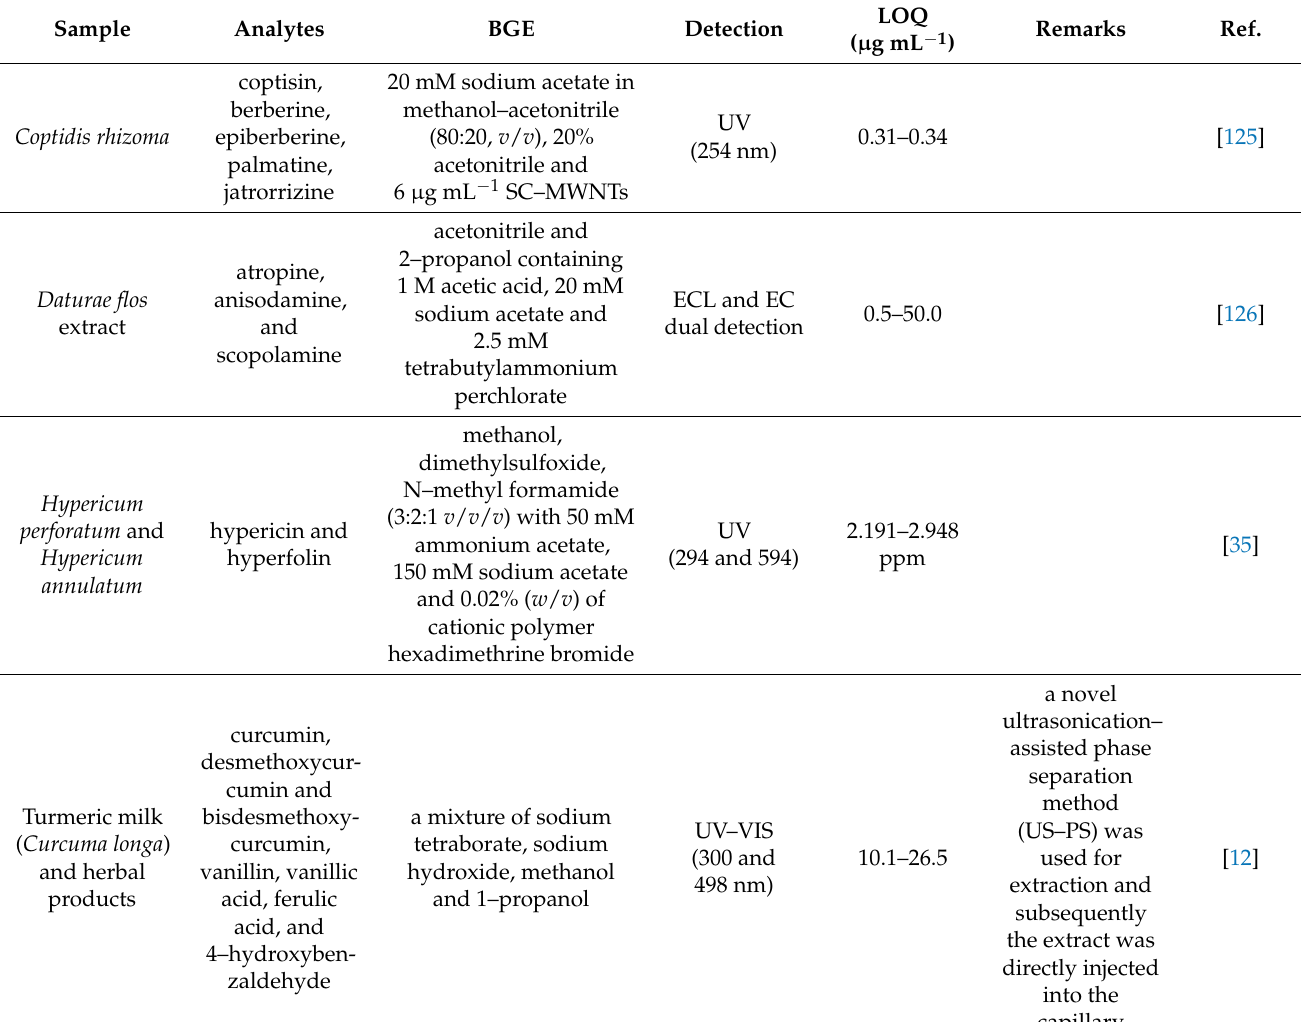
Table 3. Application of nonaqueous capillary